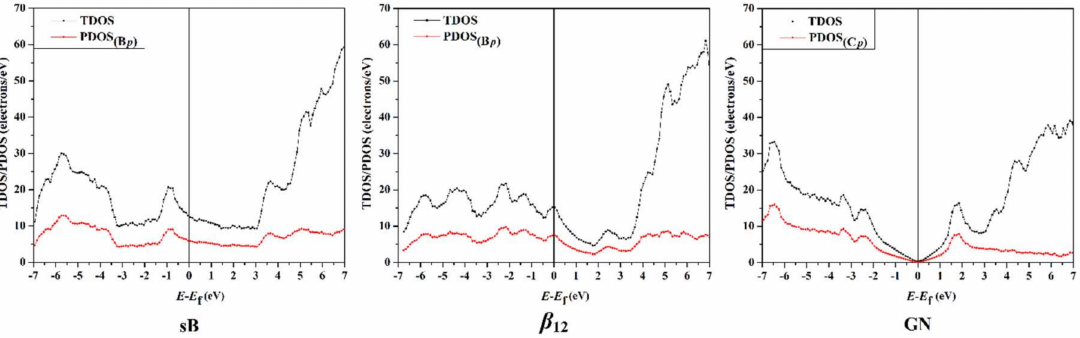
Figure 7. The total and projected density-of-states (TDOS/PDOS) plots for the pure surfaces of the sB, β 12 , and GN, assuming the Fermi level as the reference level. The values B p and C p represent the p -orbital of boron (B) and carbon (C) atoms,